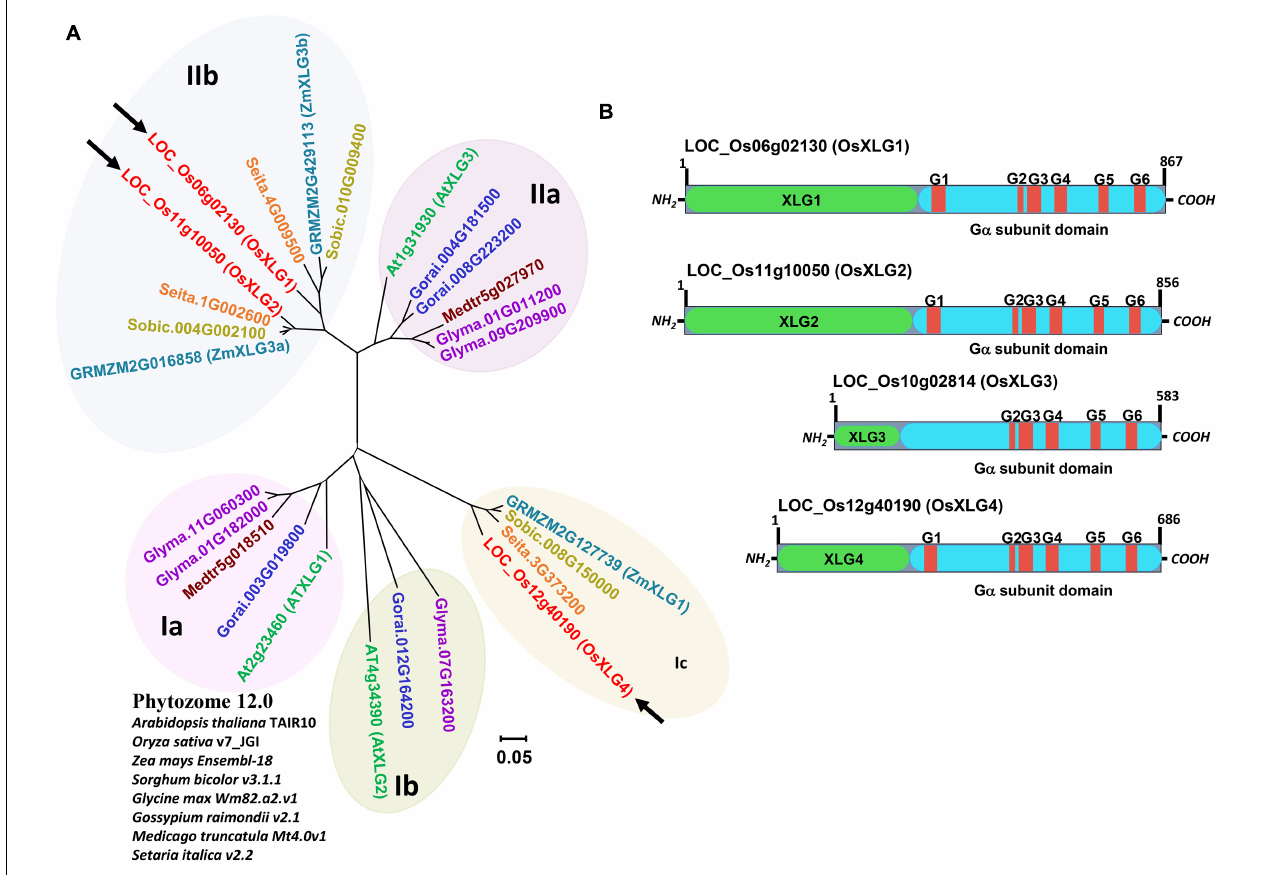
FIGURE 1 | Phylogenetic tree and protein structure of rice XLGs. (A) Phylogeny of XLG protein sequences. Sequences were retrieved from Arabidopsis thaliana TAIR10 (green), O. sativa v7.0 (red), Zea mays Ensembl-18 (turquoise), Sorghum bicolor v3.1.1 (dark yellow), Glycine max Wm82.a2.v1 (purple), Gossypium raimondii v2.1 (blue), Medicago truncatula Mt4.0v1 (dark red), and Setaria italica (orange) from Phytozome 12.0 (https://phytozome.jgi.doe.gov/). LOC_Os06g02130, LOC_Os11g10050, and LOC_Os12g40190 (in red fonts with black arrow) are named in this paper as OsXLG1, OsXLG2, and OsXLG4. The tree was constructed by the neighbor-joining method using MEGA7 (Kumar et al., 2016). (B) Schematic diagram of rice XLG domain architecture. Domains unique to the XLG family are shown in green boxes. Turquoise color represents homologous G α subunit sequence. Conserved amino acid sequences shown in red rectangle with G#s represent motifs involved in GTP-binding.